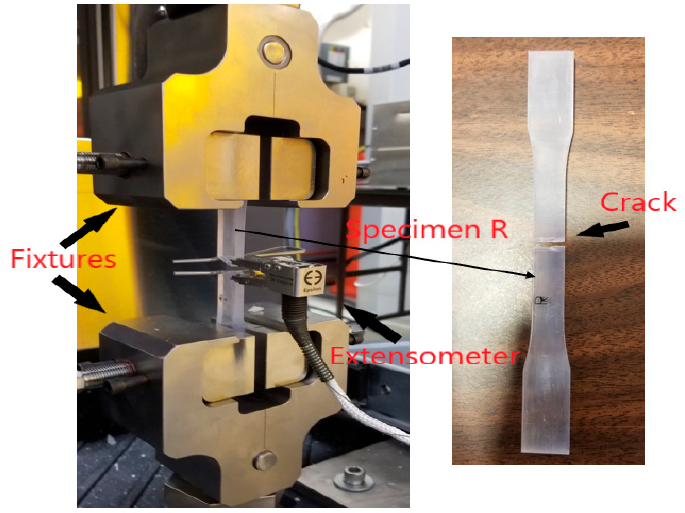
Figure 10. The axial extensometer engaged with a test specimen.